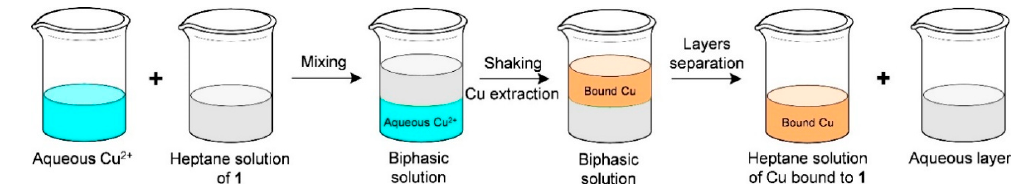
Figure 1. Schematic representation of copper sequestration from aqueous solution. Table 1. Results of metal sequestration by 1 from model solutions under biphasic conditions.